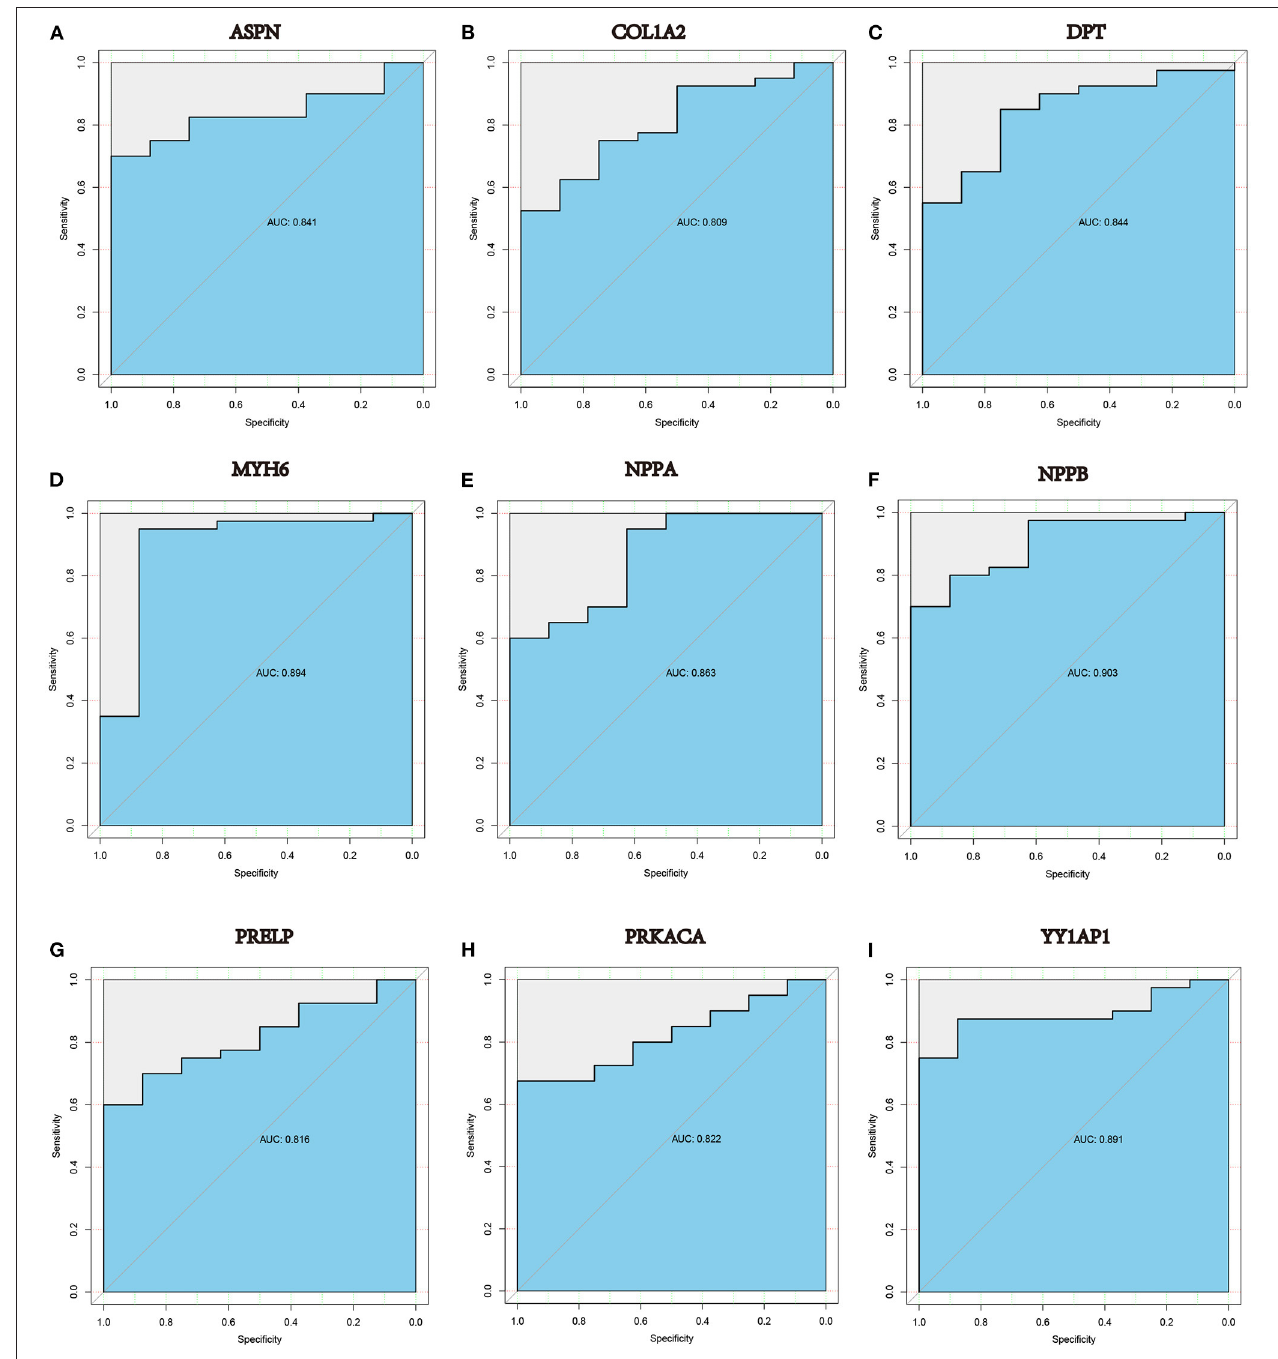
FIGURE 7 | ROC curve analysis in GSE17800 demonstrated that (A) ASPN, (B) COL1A2, (C) DPT, (D) MYH6, (E) NPPA, (F) NPPB, (G) PRELP, (H) PRKACA and (I) YY1AP1 may be diagnostic biomarkers in patients with DCM. AUC: area under the curve.